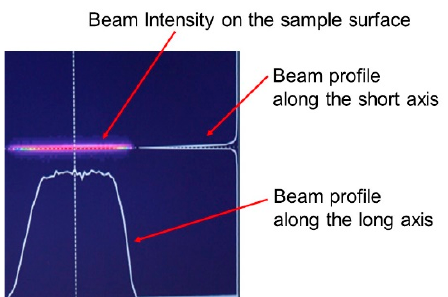
Figure 7. Beam profile of highly top-flat line beam (arbitrary unit). After Sasaki et al. [44].